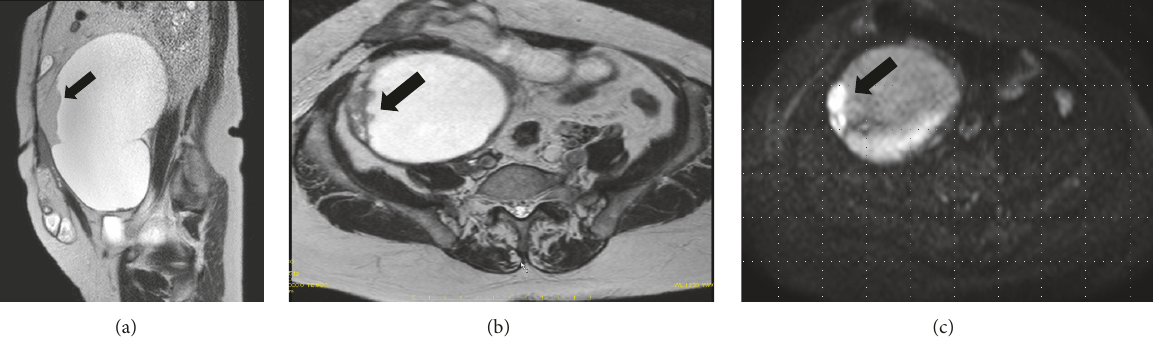
Figure 2: Pelvic plain magnetic resonance imaging. (a) T2-weighted image in the sagittal plane. A cyst measuring 21 × 19 × 12 cm is observed. It is partially solid. (b) T2-weighted image in the horizontal plane. (c) Diffusion-weighted image in the horizontal plane. The solid components observed on the T2-weighted image show high signal intensity on the diffusion-weighted image ( (cid:2) ). The cyst is suspected to be a malignant